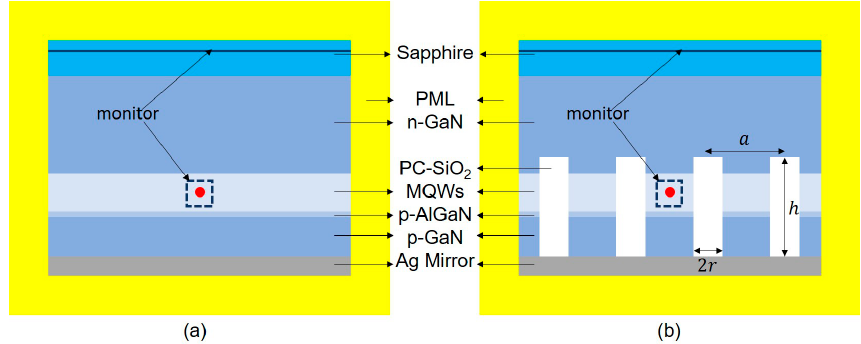
Figure 1. Model of ( a ) the conventional planar flip-chip light-emitting diodes (LED) and ( b ) the flip-chip LED with photonic crystals. Red dots inside multiple quantum wells (MQWs) represent the position of the dipole source.